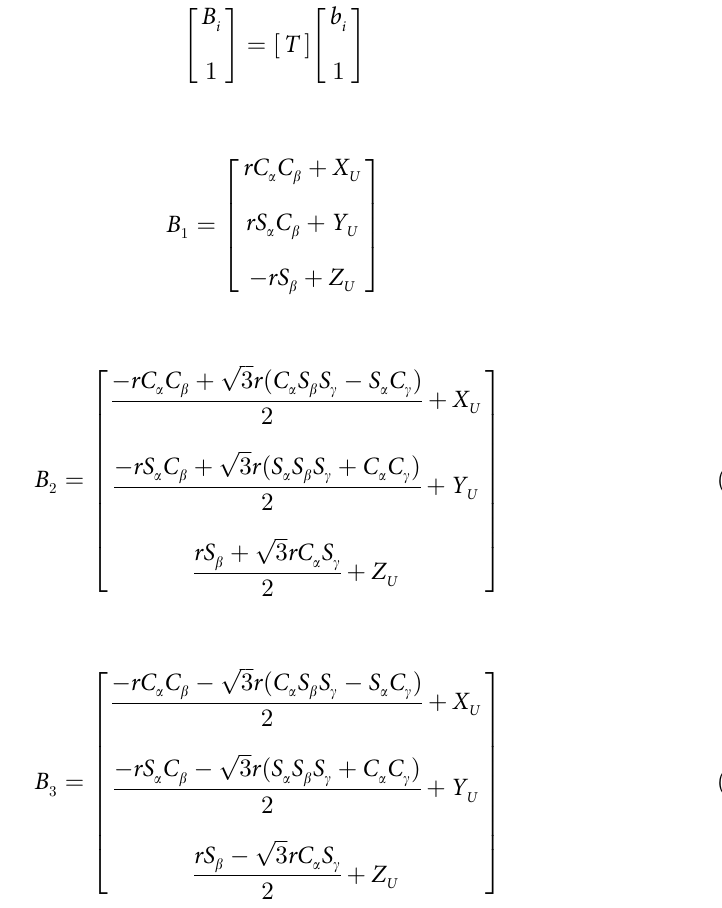
Actuators’ positions on X frame identify the constraints of the kinematics as illustrated in Fig 6A. The constraint equations are stated for each actuator’s static body as y tor’s constrain plane), y